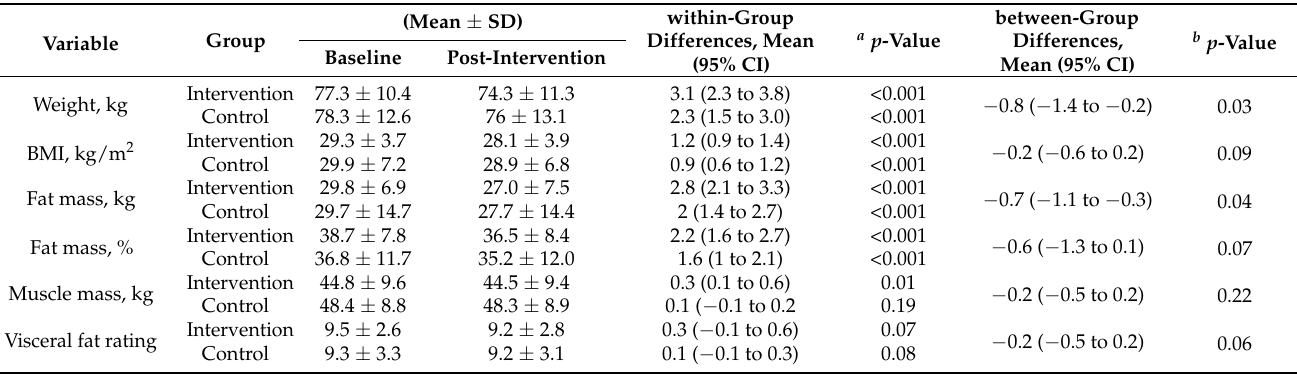
Table 6. Body composition parameters at baseline and